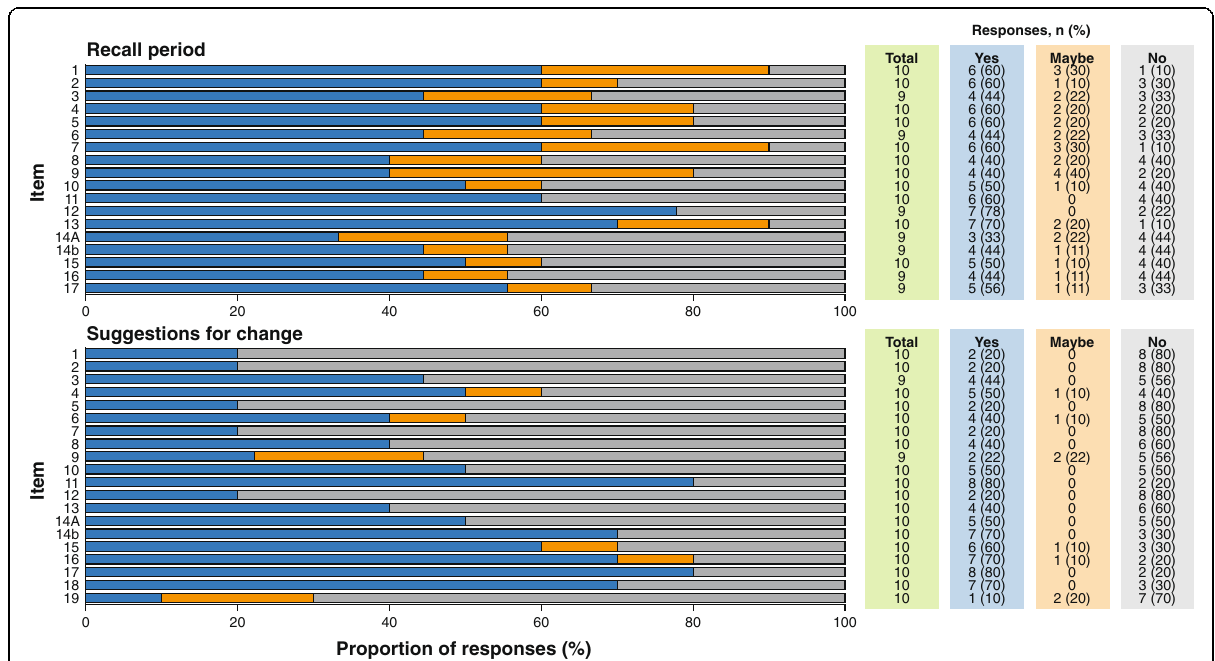
Fig. 4 Participant responses regarding the TASQ-IV items by item debrief; recall period and suggestions for